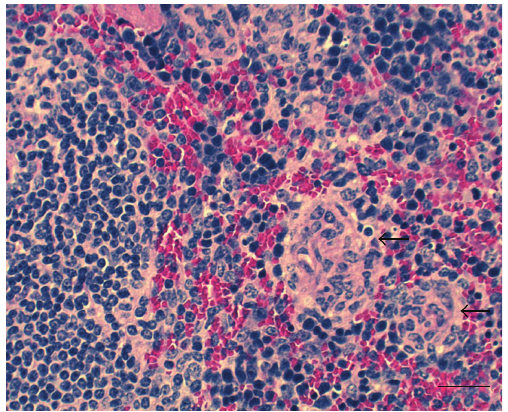
Figure 1: Spleen of BALB/c mouse at 21 days of infection by Brucella melitensis . The mouse was intragastrically infected with 10 5 CFU of B. melitensis 16M. Microgranulomas in red pulp (arrows). HE. Bar: 100 μ